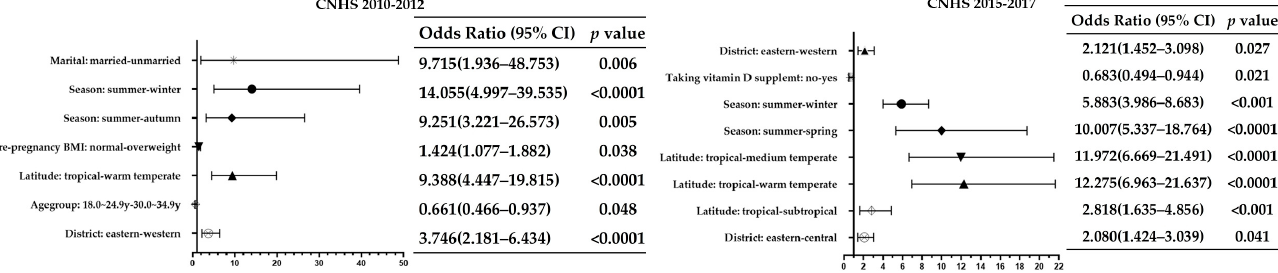
Figure 1. Risk factors for vitamin D inadequacy in CNHS 2010–2012 and CNHS 2015–2017 (vitamin D insufficiency and deficiency were grouped together as vitamin D inadequacy, 25(OH)D < 20 ng/mL).